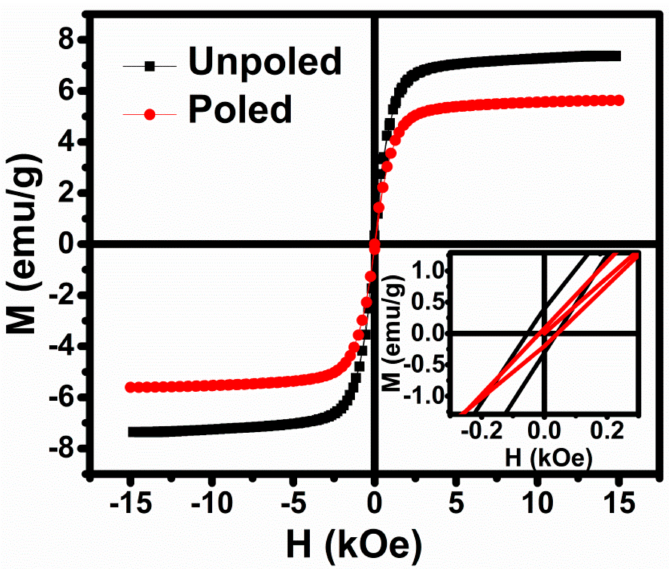
Figure 6. M vs. H data of PC10 composite taken before and after electric field poling; the inset shows the effect poling on the low magnetic field